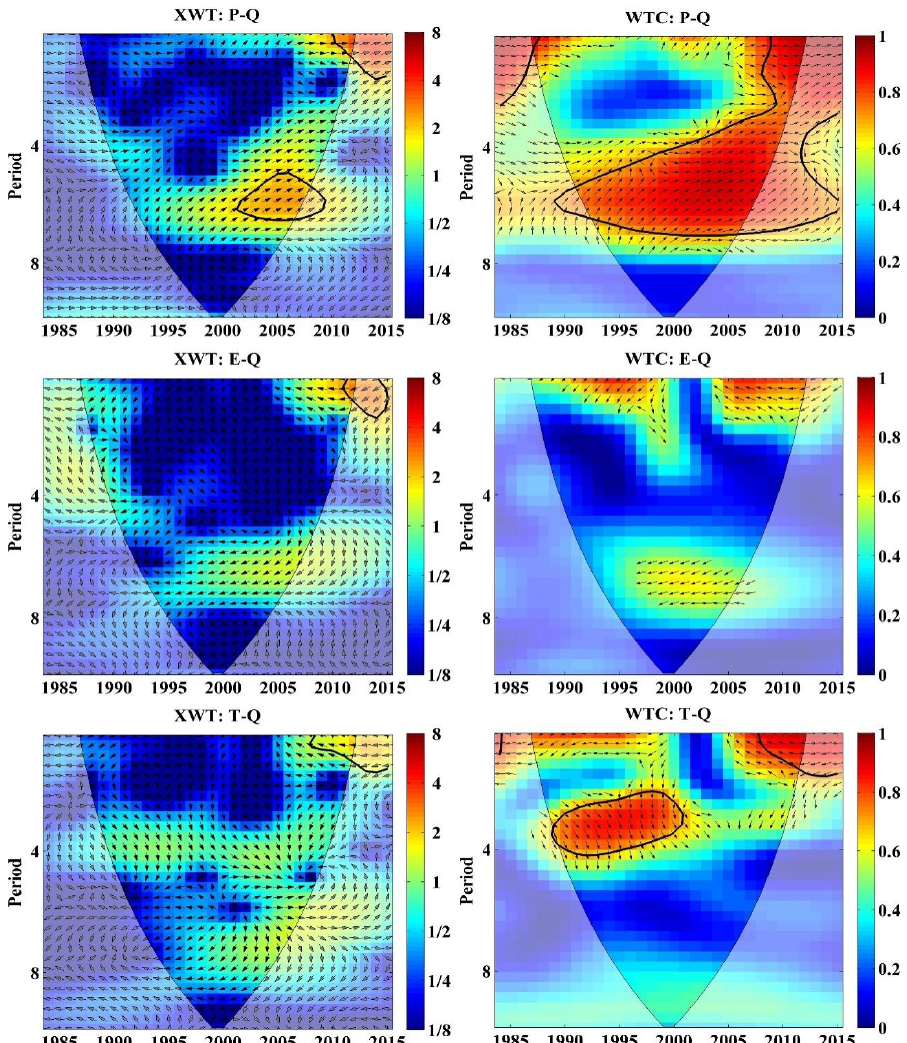
Figure 16. The XWT and WTC for annual rainfall (P) and runoff (Q), evaporation (E) and runoff (Q) and temperature (T) and runoff (Q) in the Yinjiang River watershed from 1984 to 2015. The thick black contour designates the 5% significance level against red noise and the cone of influence (COI) where edge effects might distort the picture is shown as a lighter shade.Arrows denote relative phase difference: The arrows from left to right indicate that the influencing factors and runoff are in the same phase, which implies a positive correlation; the arrows from right to left indicate an inverse phase, which implies a negative correlation; the downward arrows indicate that the influence factor is 90° ahead of the runoff change and the upward arrows indicate that the influence factor is 90° lagging the runoff.